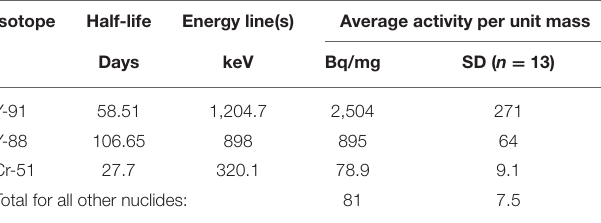
TABLE 2 | MDS Nordion measurement of by-products at 60 days post-calibration for TheraSphere with Calibration dates after January 1, 2010. Isotope Half-life Energy